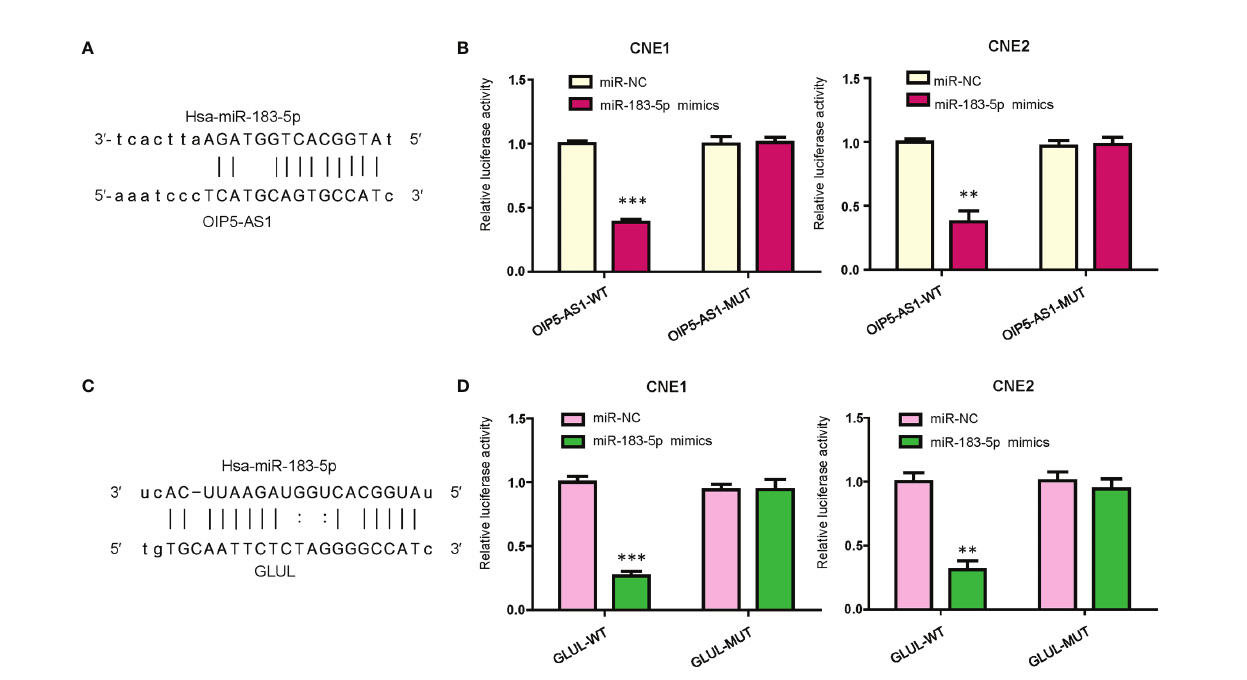
FIGURE 3 | OIP5-AS1 targets miR-183-5p. (A), Potential binding sites between OIP5-AS1 and miR-183-5p are shown. (B), Dual luciferase reporter assays were used to verify the binding sites of miR-183-5p to OIP5-AS1. **P<0.01; ***P<0.001 vs control. (C), Potential binding sites between GLUL and miR-183-5p are shown.